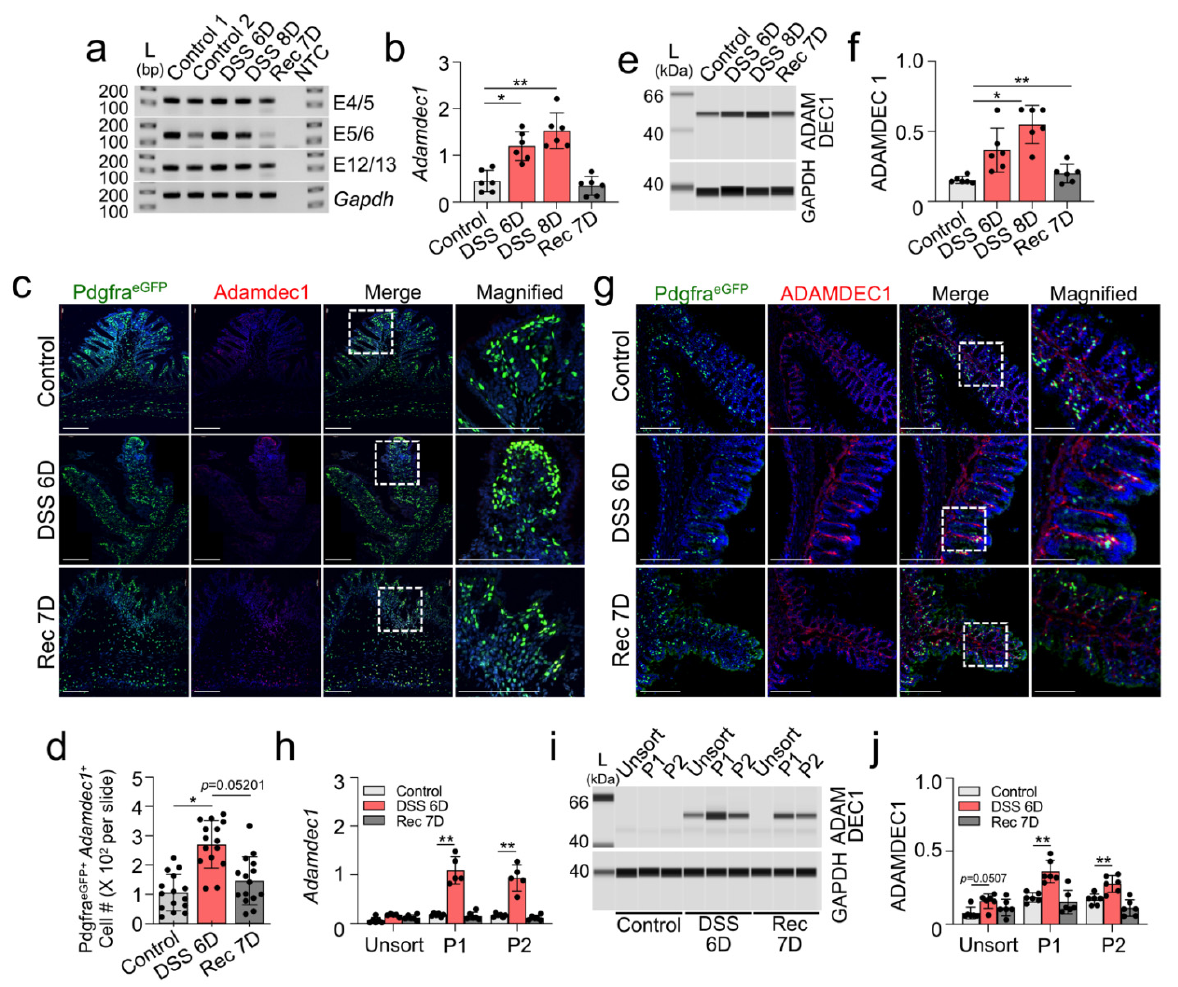
Figure 3. Induction of ADAMDEC1 in PDGFR α + cells in DSS-induced colitis. ( a ) Expression of Adamdec1 in DSS-induced colonic mucosa at 6 and 8 days post DSS treatment (DSS 6D and 8D) and recovery mucosa at 7 days (Rec 7D: switched to water after DSS treatment) measured by RT-PCR. Three independent primer sets spanning exons E4/5, E5/6, and E12/13 of Adamdec1 were used. ( b ) Quantitative analysis of Adamdec1 mRNA expression in DSS-induced colonic mucosa and recovery mucosa ( n = 5–7) measured by qPCR. Gapdh was used as an endogenous control. ( c ) RNA in situ hybridization showing increased expression of Adamdec1 in PDGFR α + cells ( Pdgfra-eGFP + cells) in DSS-induced colitis. Scale bars are 100 µ m. The dotted white box in the “Merge” image indicates the selected area of zoom for the “Magnified” image of the figure. ( d ) Quantification of number of Pdgfra-eGFP + Adamdec1 mRNA + cells in (c) ( n = 5). ( e ) Changes of ADAMDEC1 proteins in DSS- induced mucosa and recovery mucosa. GAPDH was used as a loading control. ( f ) Quantification of ADAMDEC1 in e normalized by GAPDH ( n = 6). ( g ) Increased accumulation of ADAMDEC1 in the epithelial layers of DSS-induced colonic mucosa. Scale bars are 100 µ m. The dotted white box in the “Merge” image indicates the selected area of zoom for the “Magnified” image of the figure. ( h ) Quantitative analysis of Adamdec1 mRNA expression in P1 and P2 of PDGFR α + cells isolated from DSS-induced colonic mucosa and recovery mucosa along with unsorted cells measured by qPCR ( n = 5–6). ( i ) ADAMDEC1 protein expression in P1 and P2 of PDGFR α + cells isolated from DSS-induced colonic mucosa and recovery mucosa along with unsorted cells. ( j ) Quantification of ADAMDEC1 in (i) normalized by GAPDH ( n = 6). * p < 0.05 and ** p < 0.01, versus control